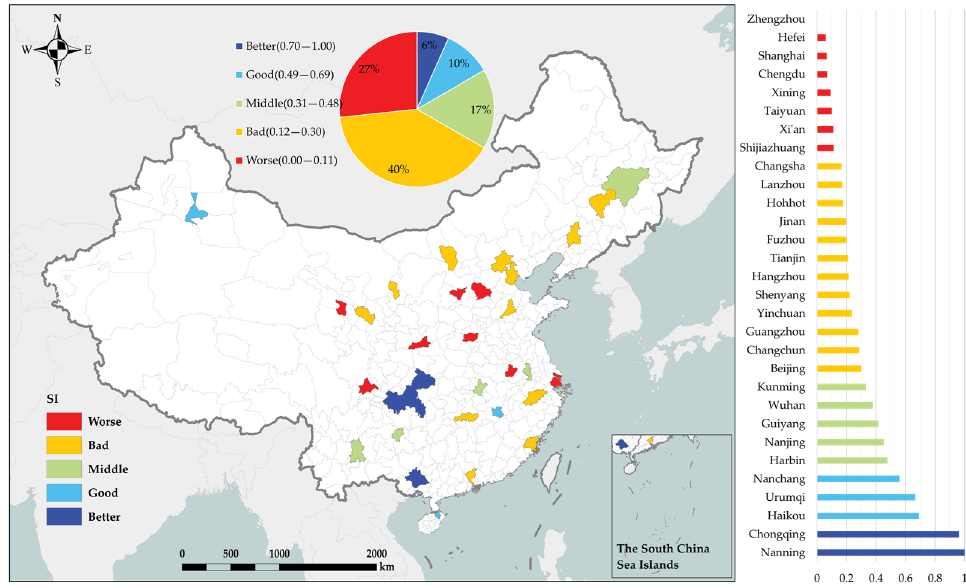
Figure 7. State index map.